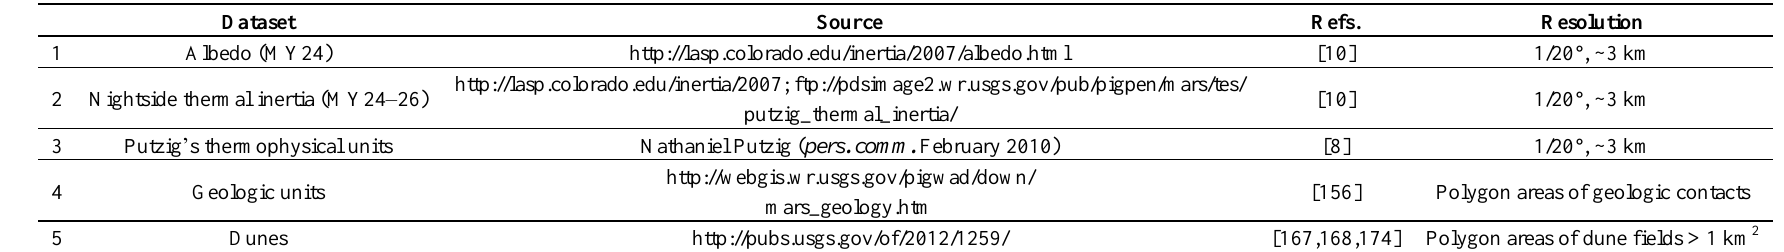
Table A1. Global datasets for Mars.